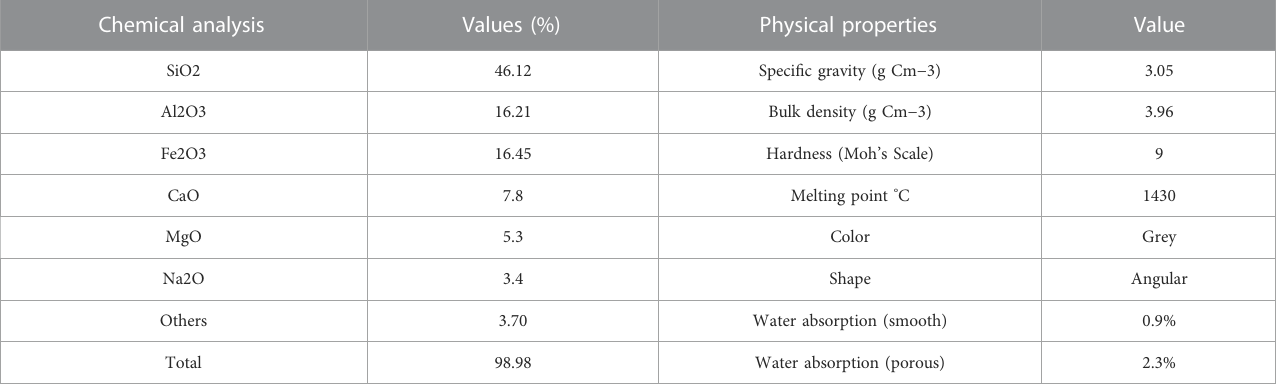
TABLE 2 Physical and chemical properties of DHA. Chemical